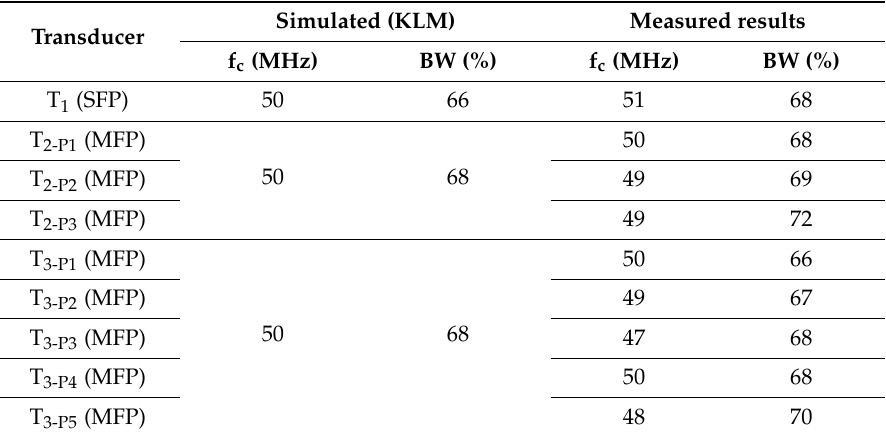
Table 3. Comparison between simulated and measured results.